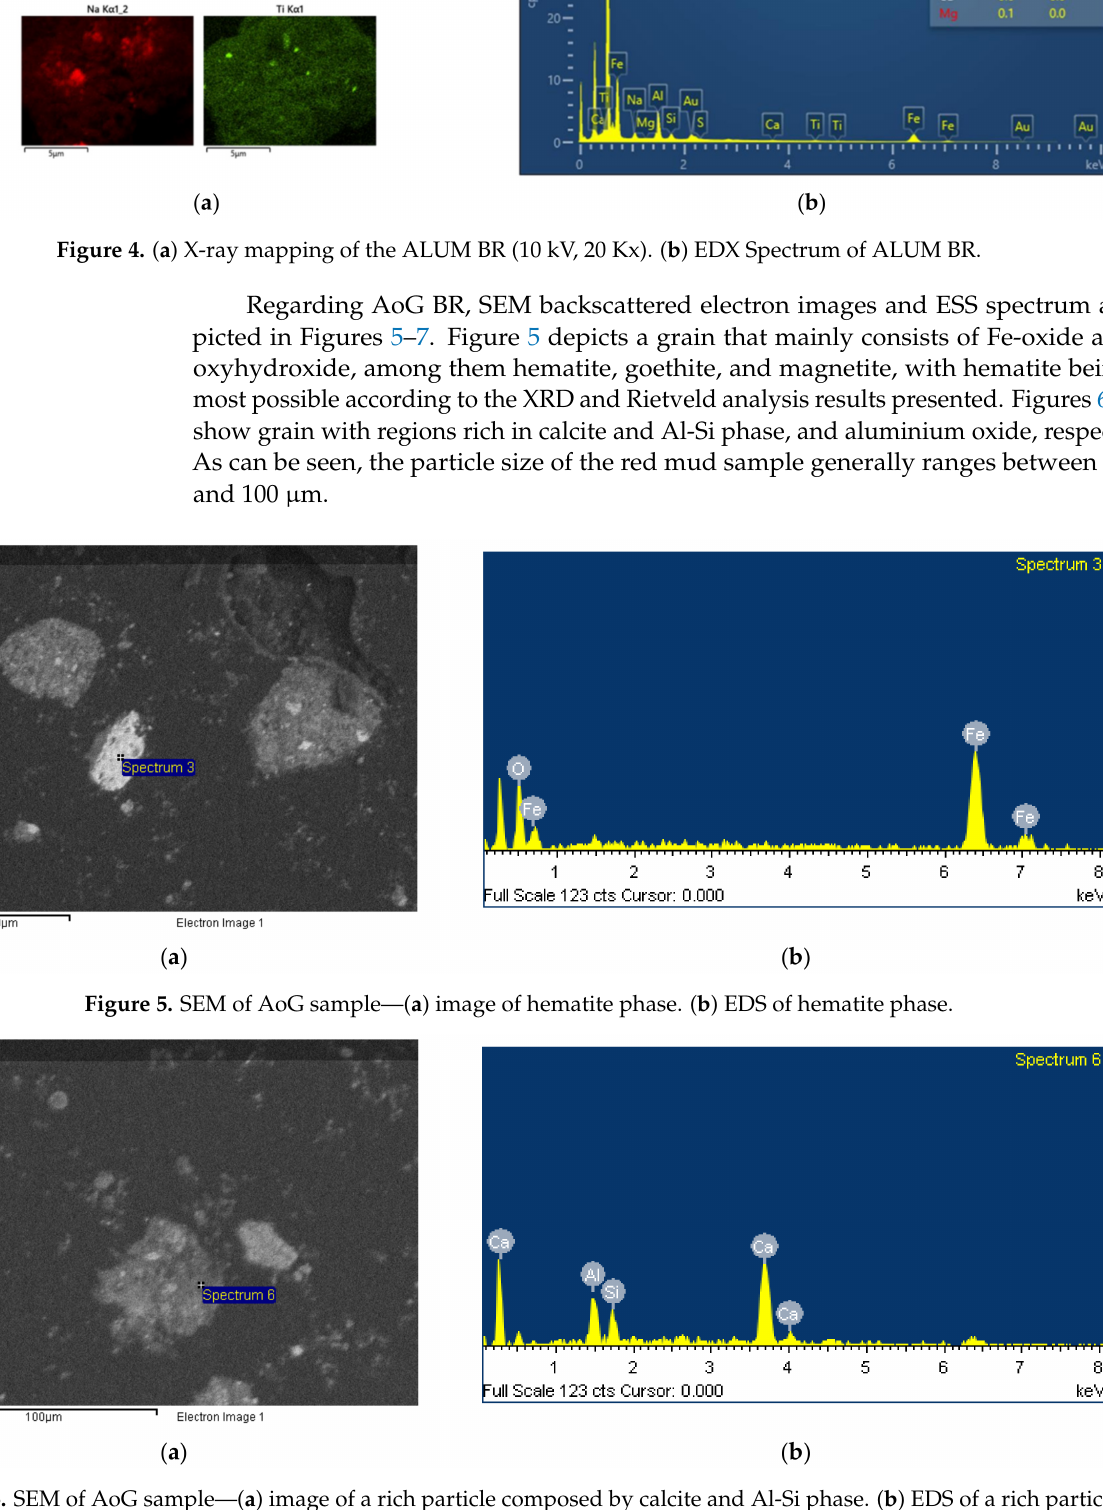
Figure 6. SEM of AoG sample—( a ) image of a rich particle composed by calcite and Al-Si phase. ( b ) EDS of a rich particle composed of calcite and Al-Si